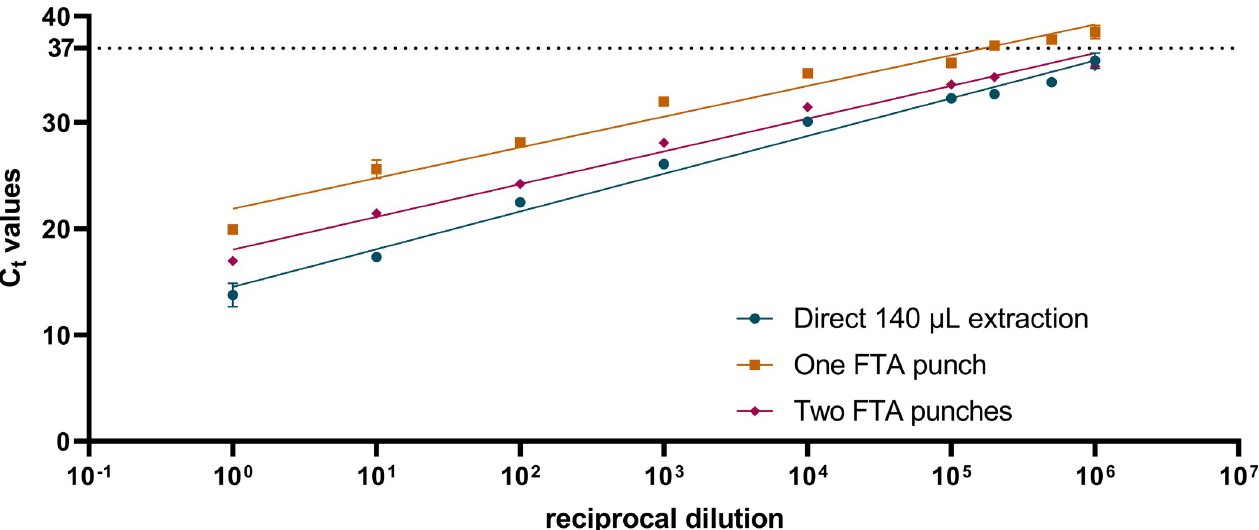
Fig 2. YFV spiked into serum can be extracted from FTA cards but with lower sensitivity than traditional methods. RNA from the vaccine strain of YFV, 17D-204, was extracted using the manufacturers protocol from 140 μ L of YFV diluted in serum, from a single FTA punch, and from two FTA punches. The dotted line at C t value 37 indicates the cut-off for YFV RNA positivity and is based on cutoffs used in the molecular diagnosis of YFV in the field. Dilution to make the standard curve were performed in human, flavivirus negative serum. Points represent the average of two experiments and were fit using a linear